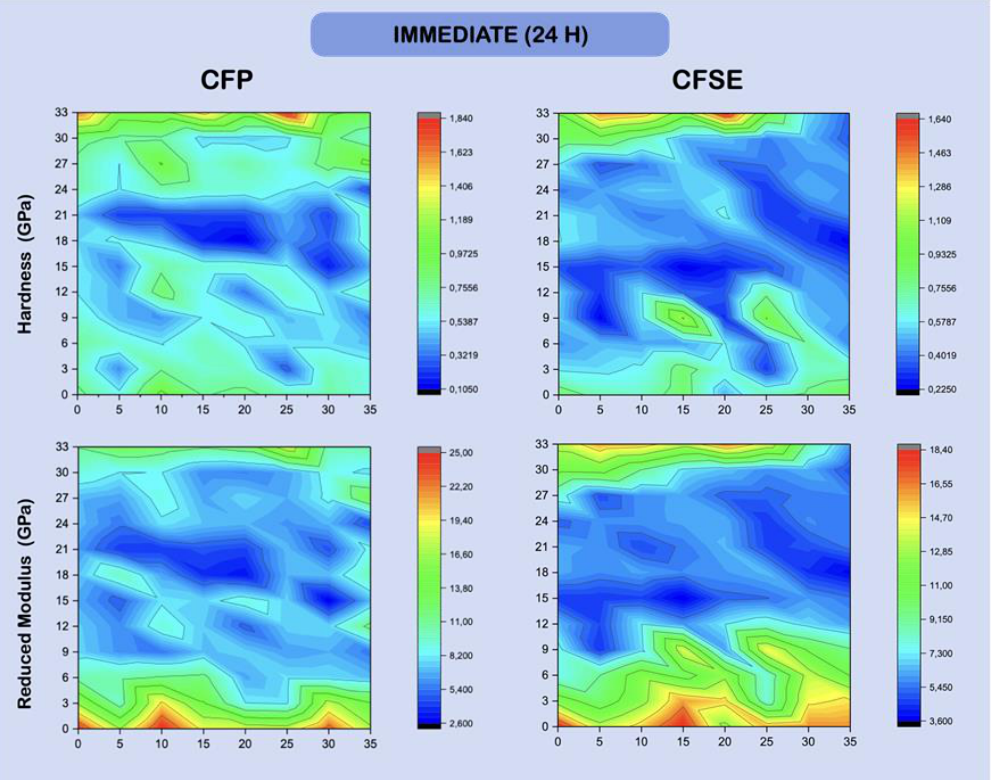
Figure 3. Hardness and reduced Young’s modulus (GPa) maps, showing the variation in intensity for each of the variables, across an area, mapping the resin-dentin interface after being restored and stored for 24 h in deionized water. Dentine is shown at the bottom, easily identifiable by the higher modulus values, while the hybrid layer is directly after (maps are representative of one random sample). Distance between points is shown in μ m.